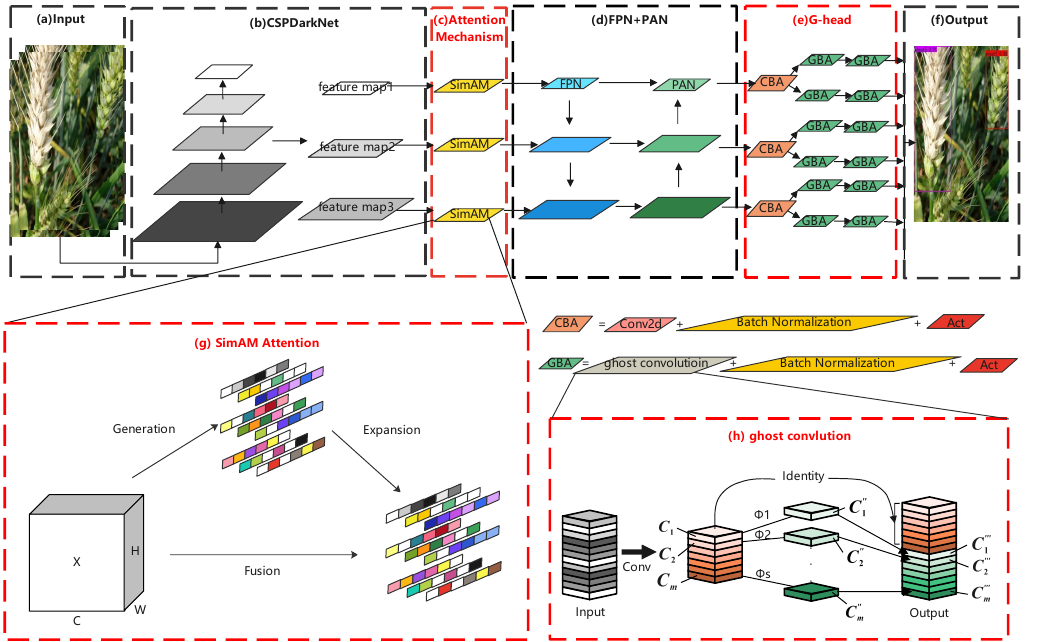
Figure 2. The structure of the